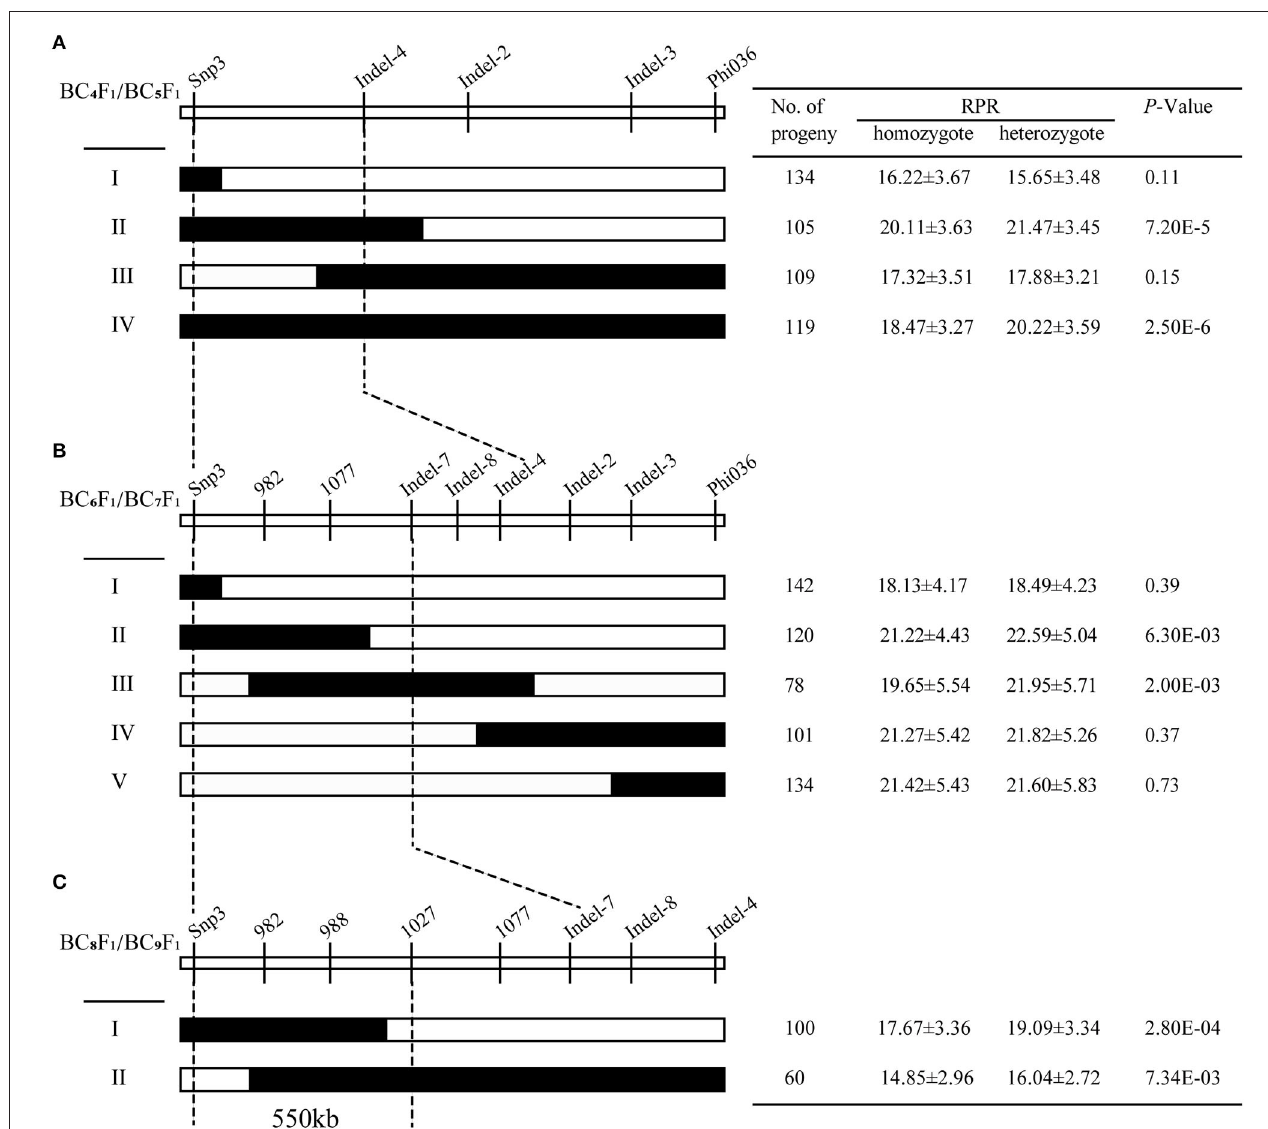
FIGURE 5 | Fine mapping of qRPR3-1 . Eight BC 4 F 1 (A) , 14BC 6 F 1 (B) , and six BC 8 F 1 (C) recombinants of qRPR3-1 were classified into four, five, and two types, respectively. In each recombinant type, the chromosomal composition of qRPR3-1 is depicted as black or white, corresponding to heterozygous 3705I/LH277 and homozygous 3705I/3705I, respectively. The black-dotted lines indicate the narrowed regions of qRPR3-1 . A significant difference ( p < 0.05) between heterozygote 3705I/LH277 and homozygote 3705I/3705I indicated the presence of qRPR3-1 in the donor region. The location of qRPR3-1 was refined from a 4.5Mb region to a 550kb region flanked by the markers Snp3 and